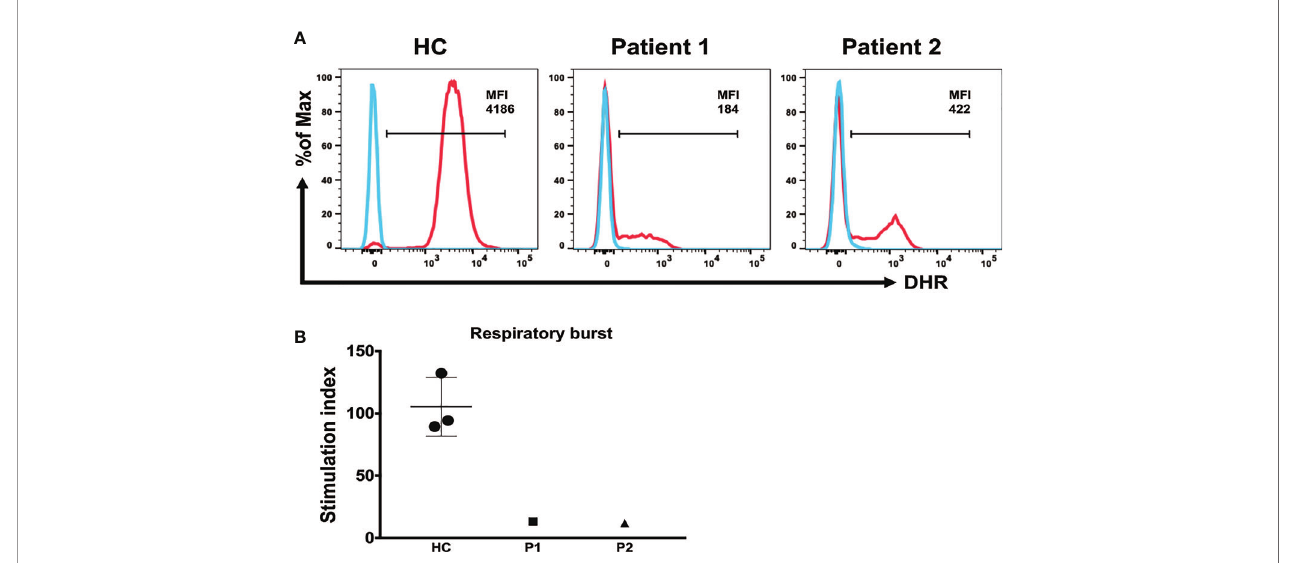
FIGURE 4 | Detection of respiratory burst activity induced by PMA stimulation. (A) Whole blood was incubated in the absence or presence of PMA, as indicated. Respiratory burst was detected via conversion of DHR-123 in neutrophils. Median fl uorescence intensity of the entire neutrophil-gated cell population, enclosed by the marker bar, is speci fi ed in each plot. (B) Mean (± SD) respiratory burst stimulation index (SI) values in healthy controls and patients 1 and